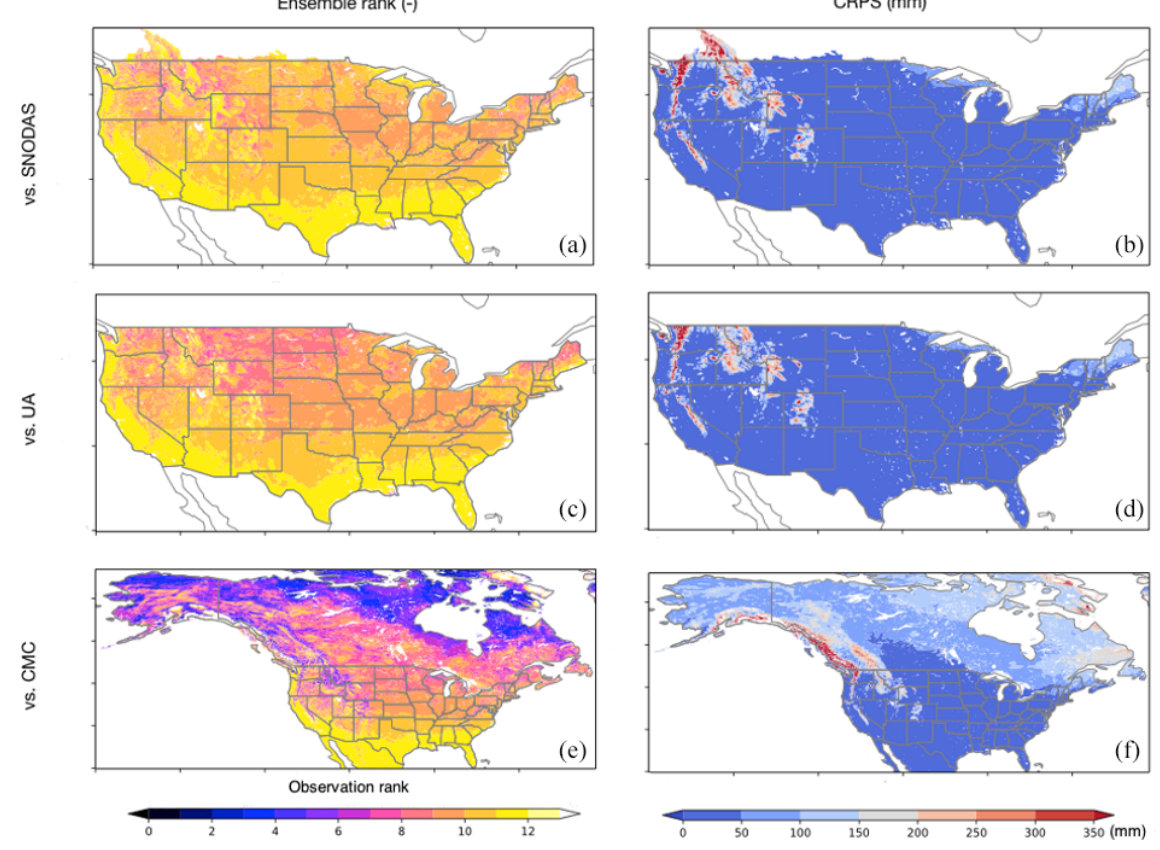
Figure 2. Maps of average ensemble rank (a, c, e) and average continuous rank probability score (CRPS, mm; b, d, f ) from the SEUP ensemble compared to SNODAS (a, b) , UA (c, d) , and CMC (e, f) . SWE is used for SNODAS and UA comparisons, whereas snow depth is used for CMC comparison. Ensemble rank represents the rank of the reference data within the SEUP ensemble. Rank 13 represents more snow than all ensembles, and rank 0 is less snow than all ensembles. CRPS, which is the extension of mean absolute error to ensemble evaluation, provides a measure of the degree of agreement between the SEUP ensemble and the reference